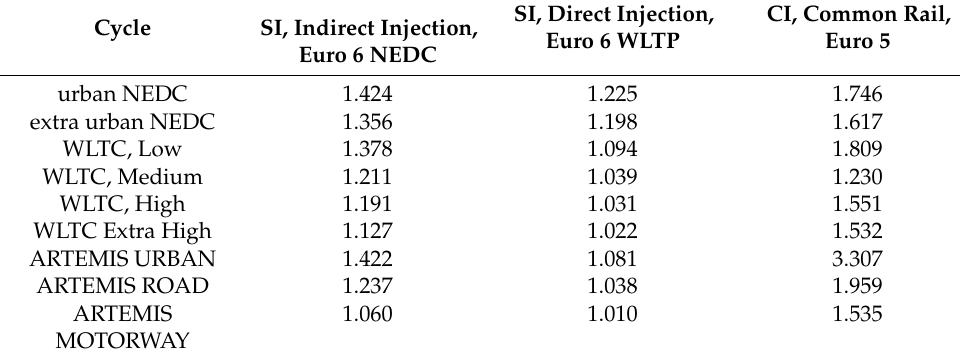
Table 3. Median of the λ in each phase of NEDC, WLTC and ARTEMIS